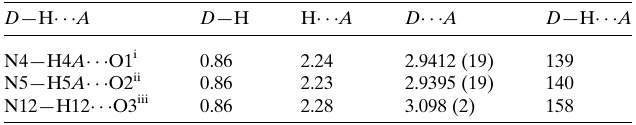
Table 1 Hydrogen-bond geometry (A˚ , (cid:2) ).